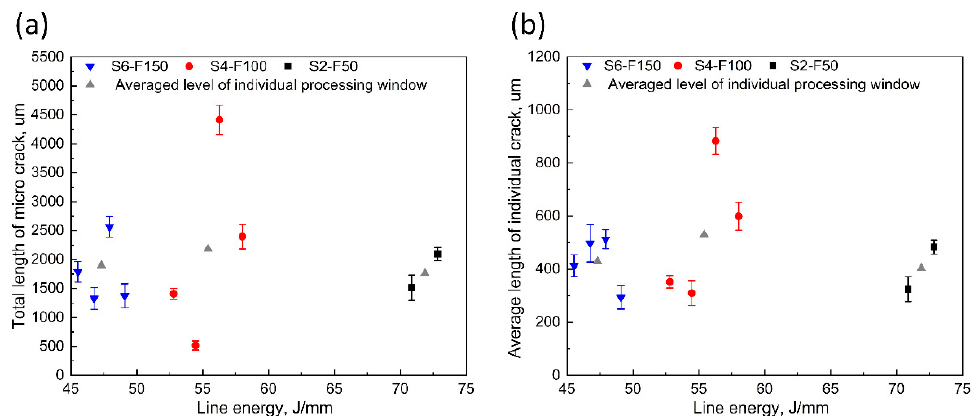
Figure 8. Distribution of ( a ) total length of all cracks and ( b ) average length of individual crack as function of welding parameters, measured by SEM on cross-sections with three replications at different positions along the welding directions for each welding condition. Grey dashed line represents the averaged level of individual processing window.